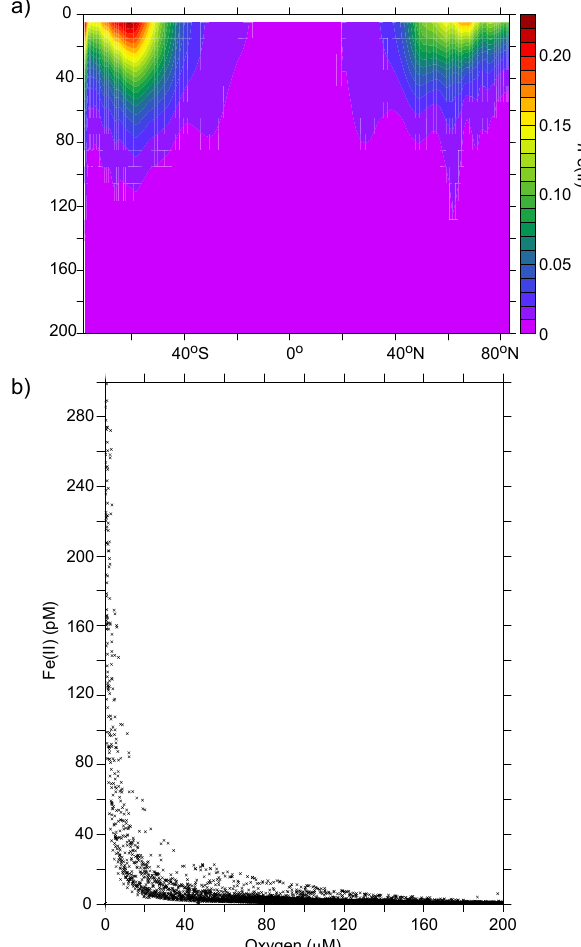
Fig. 3. (a) The zonally averaged fFe(II) for the upper 250m and (b) the relationship between Fe(II) and oxygen concentration be- tween 200 and 300m, highlighting the relative accumulation of Fe(II) in suboxic